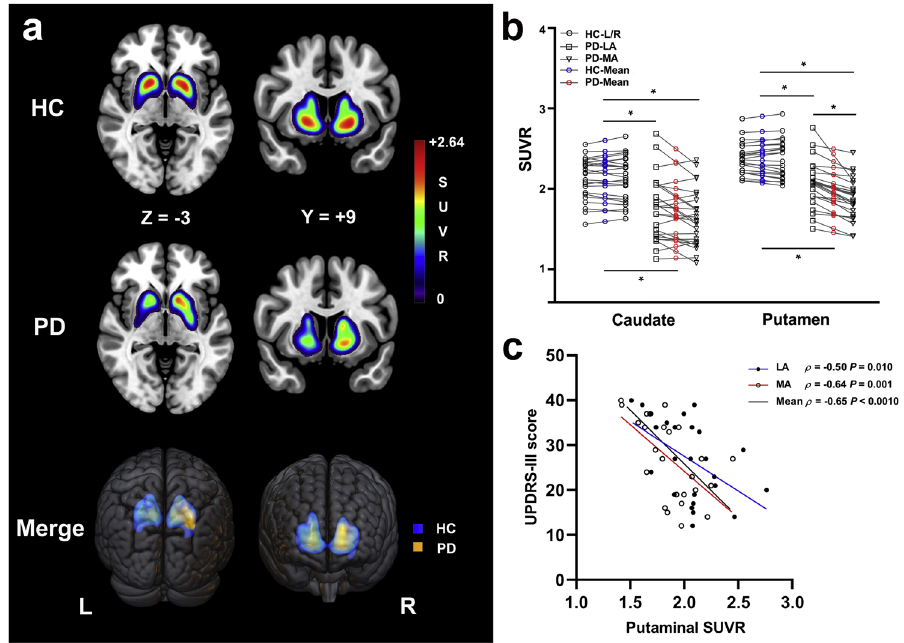
Fig. 1 18 F-DOPA SUVR parametric images and scatter plots. a Images of HC subject (M, age 62 years, MoCA score 30) and PD patient (F, age 63 years, MoCA score 29, UPDRS-III score 12, H-Y stage 1). These two parametric images were merged for the demonstration of the extent of striatal SUVR. The colorbar represents the value of SUVR. b Scatter plots of caudal and putaminal SUVR in HC subjects and PD patients. The striatal SUVR was from left and right side in HC subjects, and MA and LA side of symptom onset in PD patients separately. c Correlation between putaminal SUVR (separately for LA, MA, and mean; X -axis) and scores of UPDRS-III ( Y -axis) in PD group. * indicates signi fi cant difference ( P < 0.05) between groups. Solid line shows signi fi cant correlation. Abbreviations: 18 F-DOPA 18 F- fl uorodopa, SUVR standard uptake value ratio, M male, F female, HC healthy controls, PD Parkinson ’ s disease, UPDRS-III Uni fi ed Parkinson ’ s Disease Rating Scale III, MoCA Montreal Cognitive Assessment, H-Y Hoehn and Yahr, L left, R right, LA less affected, MA more signi fi cant clusters for the fractional anisotropy (FA) or mean diffusivity (MD) maps between the PD and HC groups. However, signi fi cantly decreased FA in the SN and increased MD in the putamen were observed in PD patients on the MA side compared with HC subjects (Fig. 2a, b). The brain regions with signi fi cant group differences in FA and MD are shown in Table 2. The FA values in the signi fi cant cluster showed a positive correlation with putaminal SUVR values and a negative correlation with UPDRS- III scores ( r = 0.43, P = 0.031; ρ = − 0.47, P = 0.017) (Fig. 2c, d). We also found that the increased MD values in the signi fi cant cluster were correlated with putaminal dopamine reduction and motor impairment ( r = − 0.46, P = 0.022; ρ = 0.56 , P = 0.003) (Fig. 2e, f).